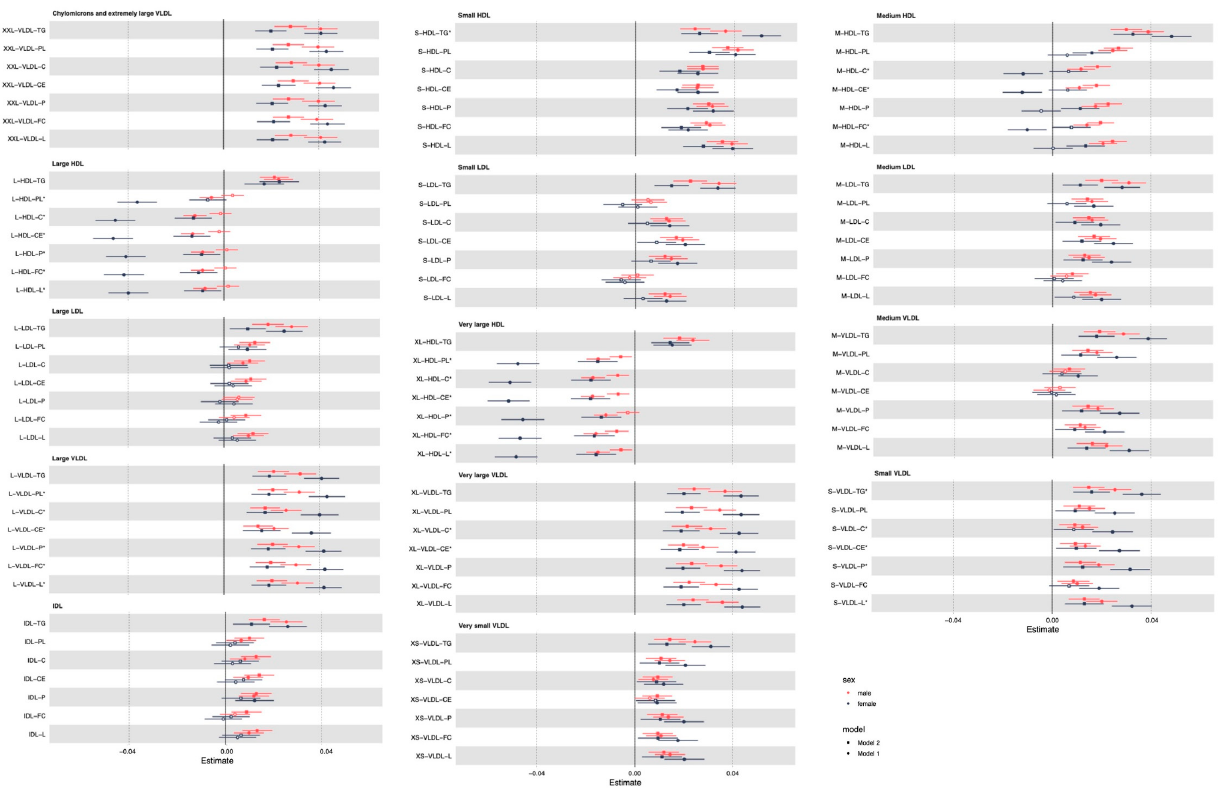
Figure 1. Associations of unprocessed red meat consumption with metabolites in men and women. ( a ) Associations with lipid subclasses. ( b ) Associations with other metabolites. Footnote: Mode l